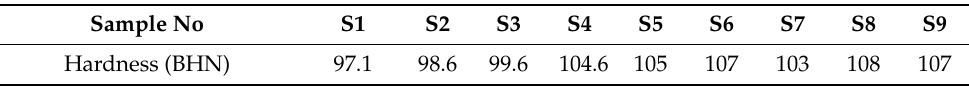
Table 4. Hardness of the fabricated